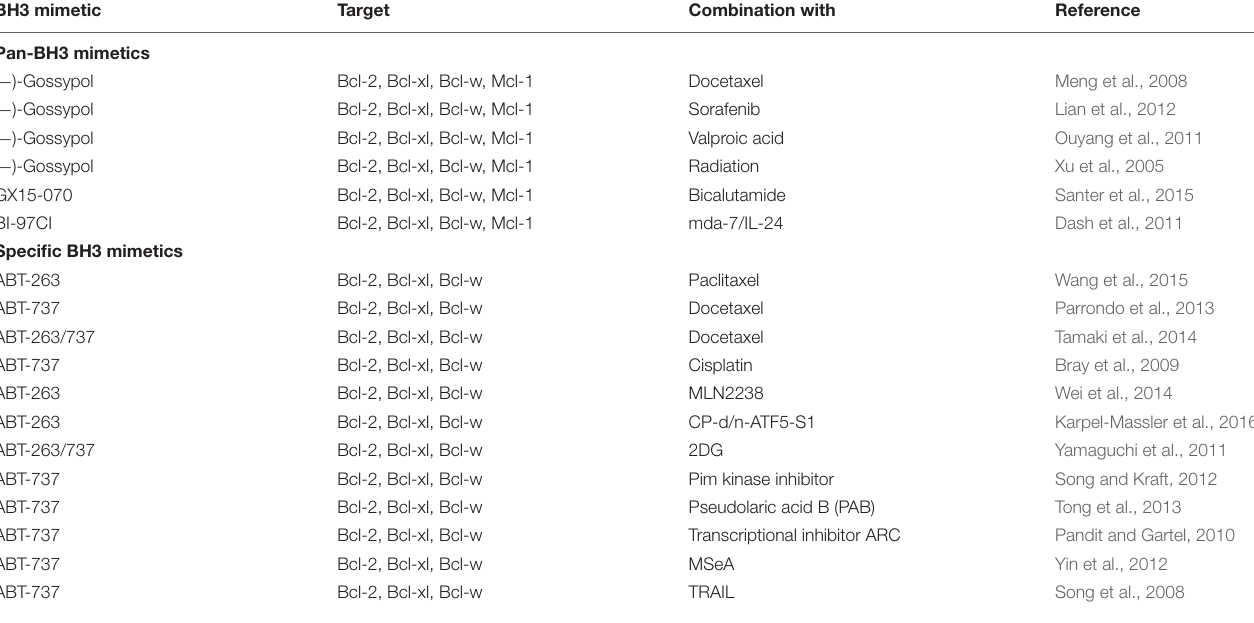
TABLE 1 | Preclinical studies of BH3 mimetics in combination with different agents against PC cells eliciting additive or synergistic cytotoxicity. BH3